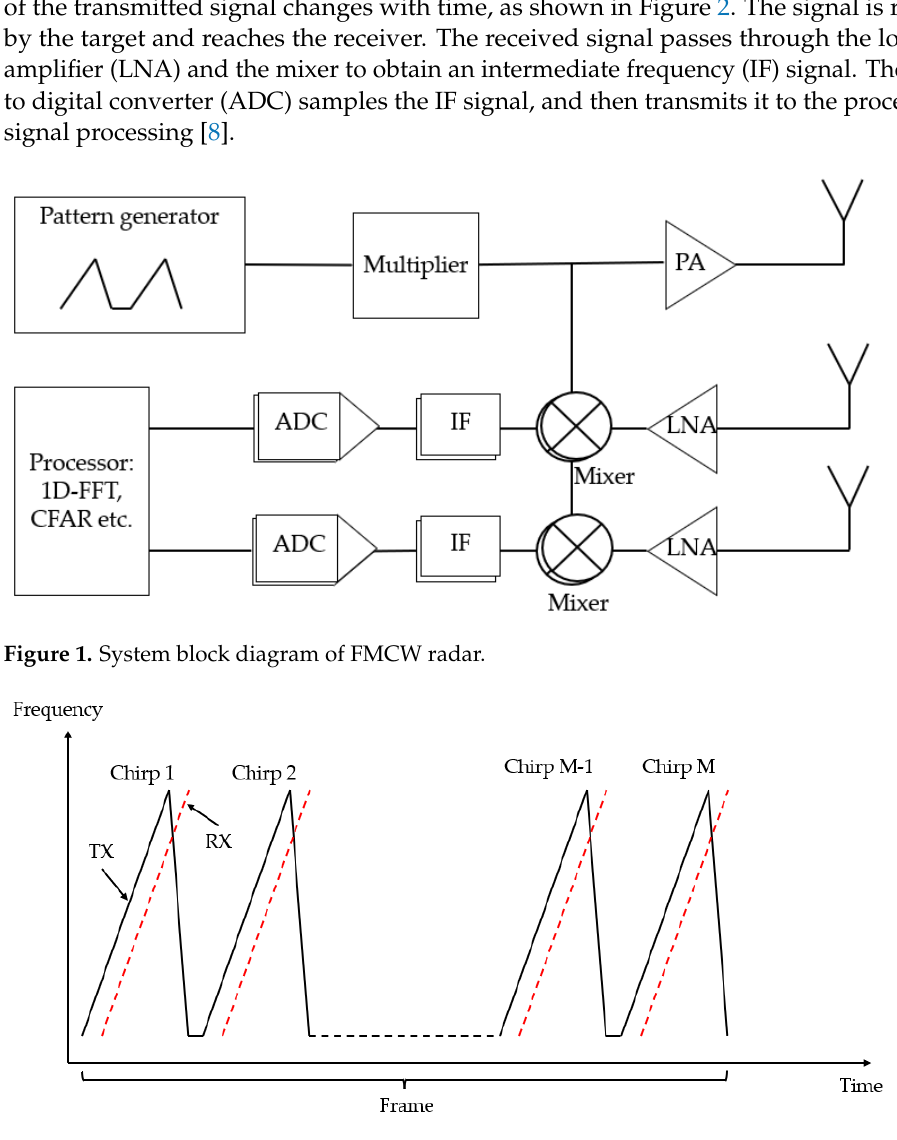
Figure 2. Transmitted and received frequency-modulated signals.